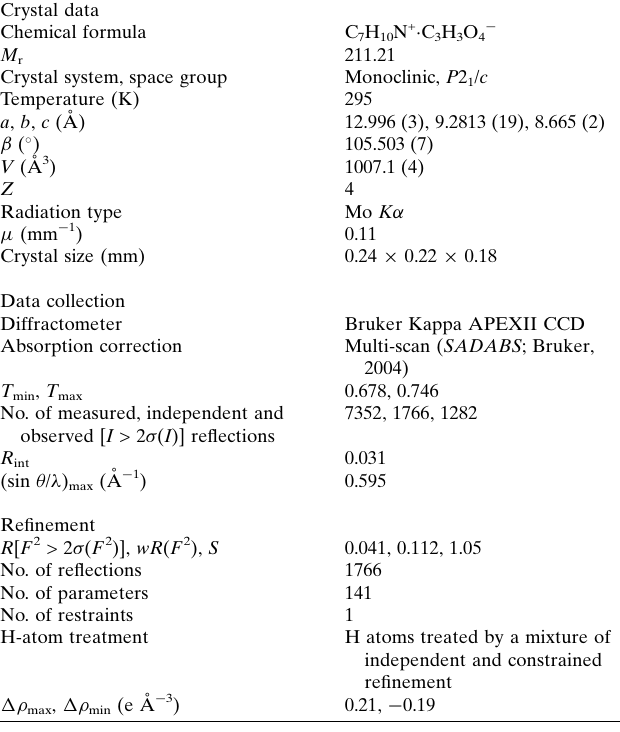
Table 2 Experimental details. Crystal data Chemical formula